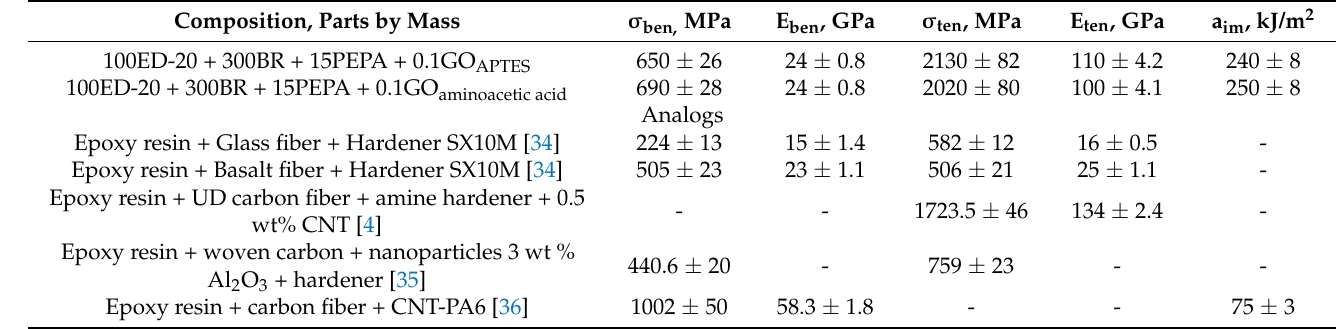
Table 6. Comparison of developed composites with